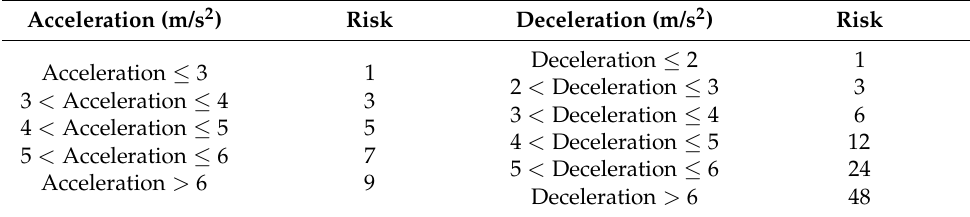
Table 3. Risk of sharp acceleration and emergency